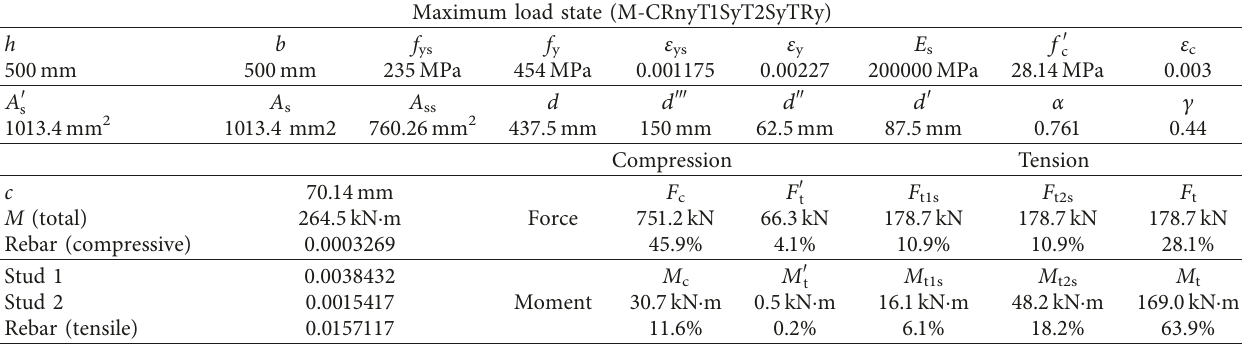
Table 6: Flexural moment capacity at the maximum load state (Specimen #2)